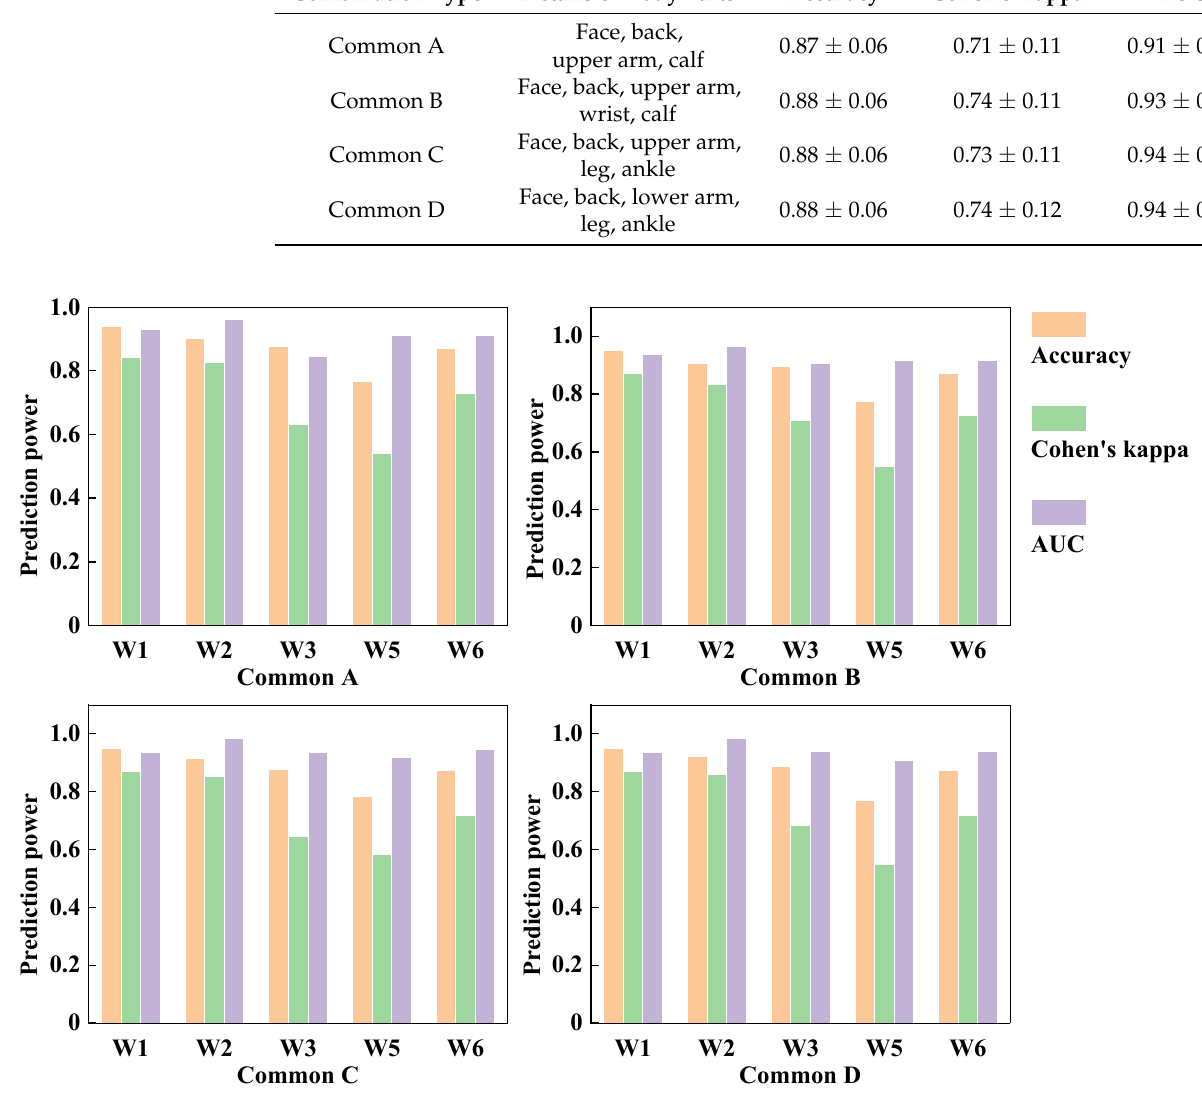
Figure 11. The prediction power of four common combinations.